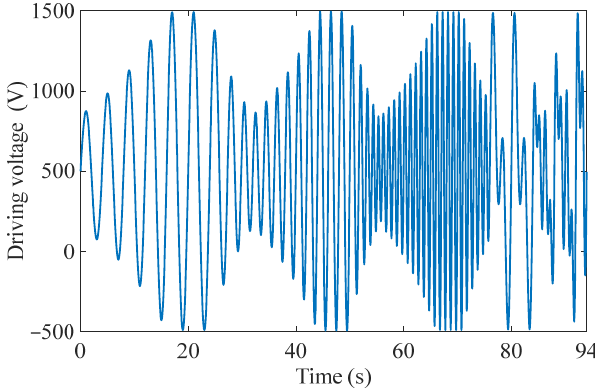
Figure 8. Excitation voltage with variable amplitudes and variable frequencies. Building the input signals as the format in (5), p = 3 and q = 3 are set. To avoid over- fitting, based on 5-fold cross-validation, two hyper-parameters C = 8.596 × 10 4 and σ = 0.6019 are obtained, and then the following fitting is realized. The experimental results, training simulation displacement results, and their errors are shown in Figure 9, and the RE is 0.3%.